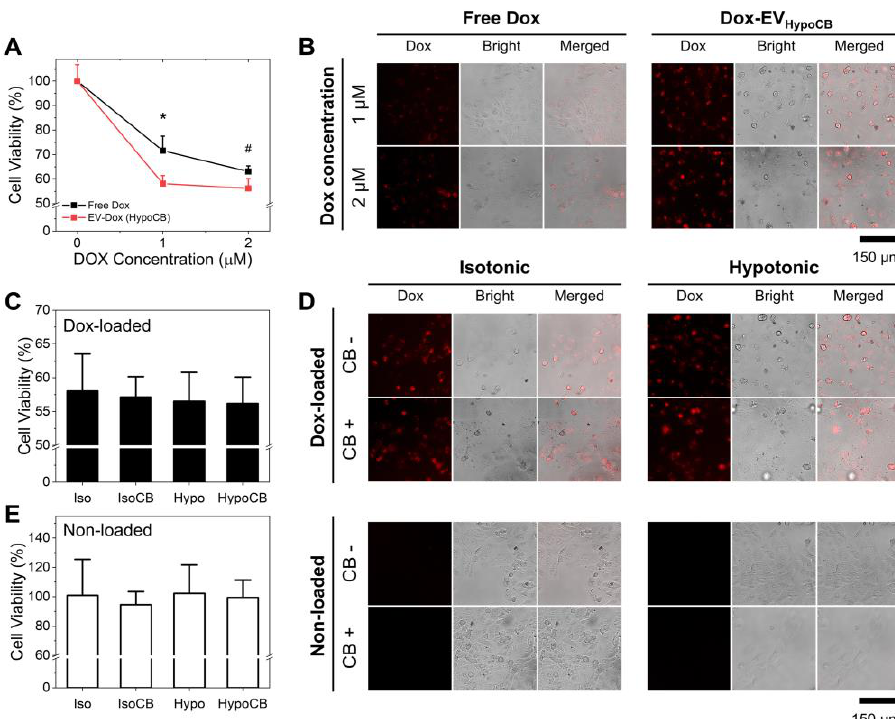
Figure 5. DOX delivery efficiency of the produced EVs: ( A , B ) The in vitro cytotoxic efficacy of the DOX-loaded hypo-CIMVs compared to the free DOX; ( C , D ) The in vitro cytotoxic efficacy of the DOX-loaded hypo-CIMVs compared to the DOX loaded in the naturally secreted EVs, CIMVs, and hypo-EVs at the DOX concentration of 2 µM; ( E ) The cytotoxicity of the EVs without DOX loading. Note that the cell viability of 100% corresponds to the viability of cells that were incubated simultaneously without addition of any EVs. Data were presented as mean ± standard deviation of three experiments ( n = 3). Significance levels are indicated as # p < 0.10 and * p < 0.05, compared to EVs obtained from the non-CB treated cells.